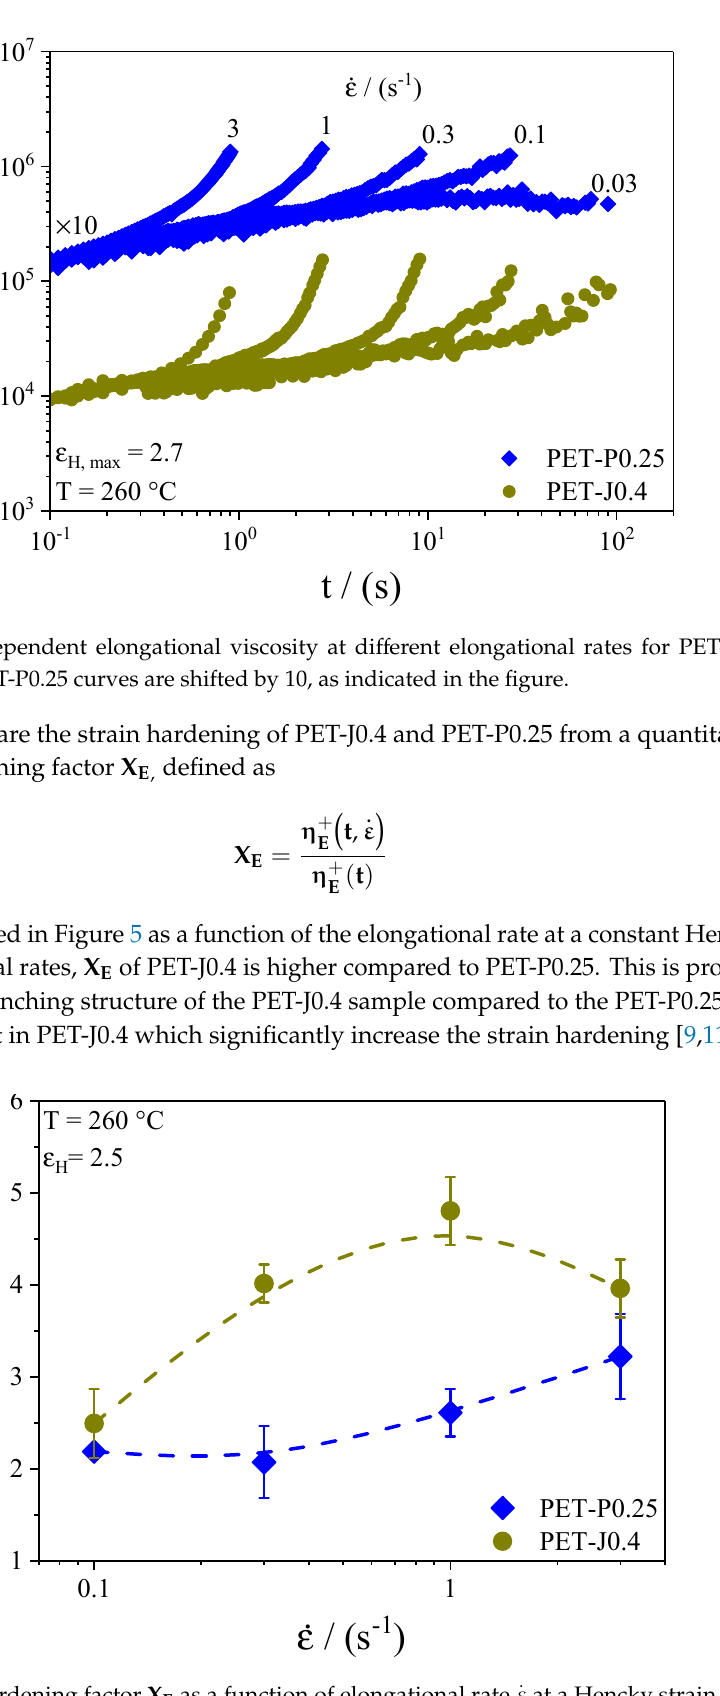
. ε at a Hencky strain of 2.5 for